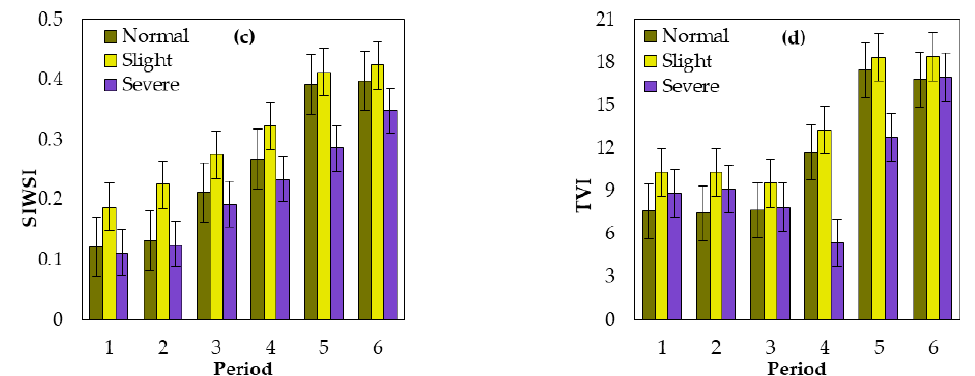
Figure 3. Mean and standard deviations of the ( a ) DSWI, ( b ) OSAVI, ( c ) SIWSI, and ( d ) TVI for both normal and infected (slight and severe) plots at different periods.